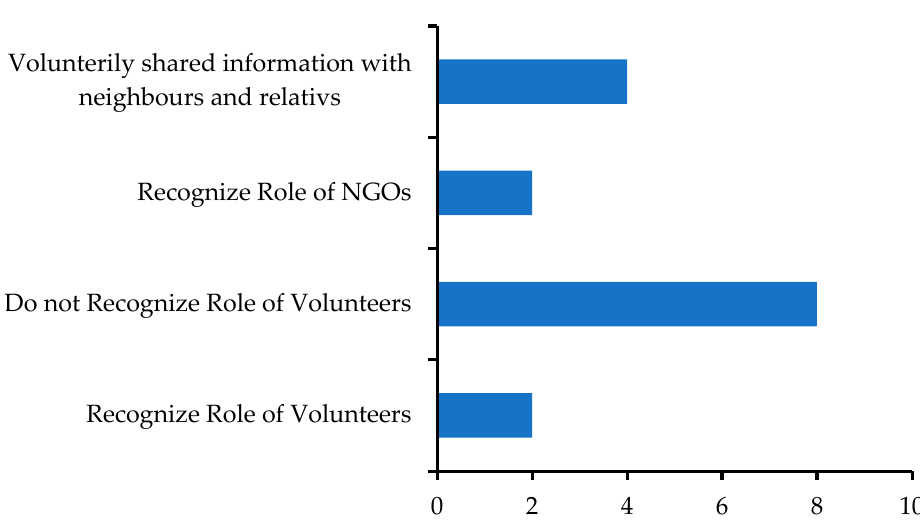
Figure 4. Recognizing the role of volunteers in FEW. Responses from the participants of this study.